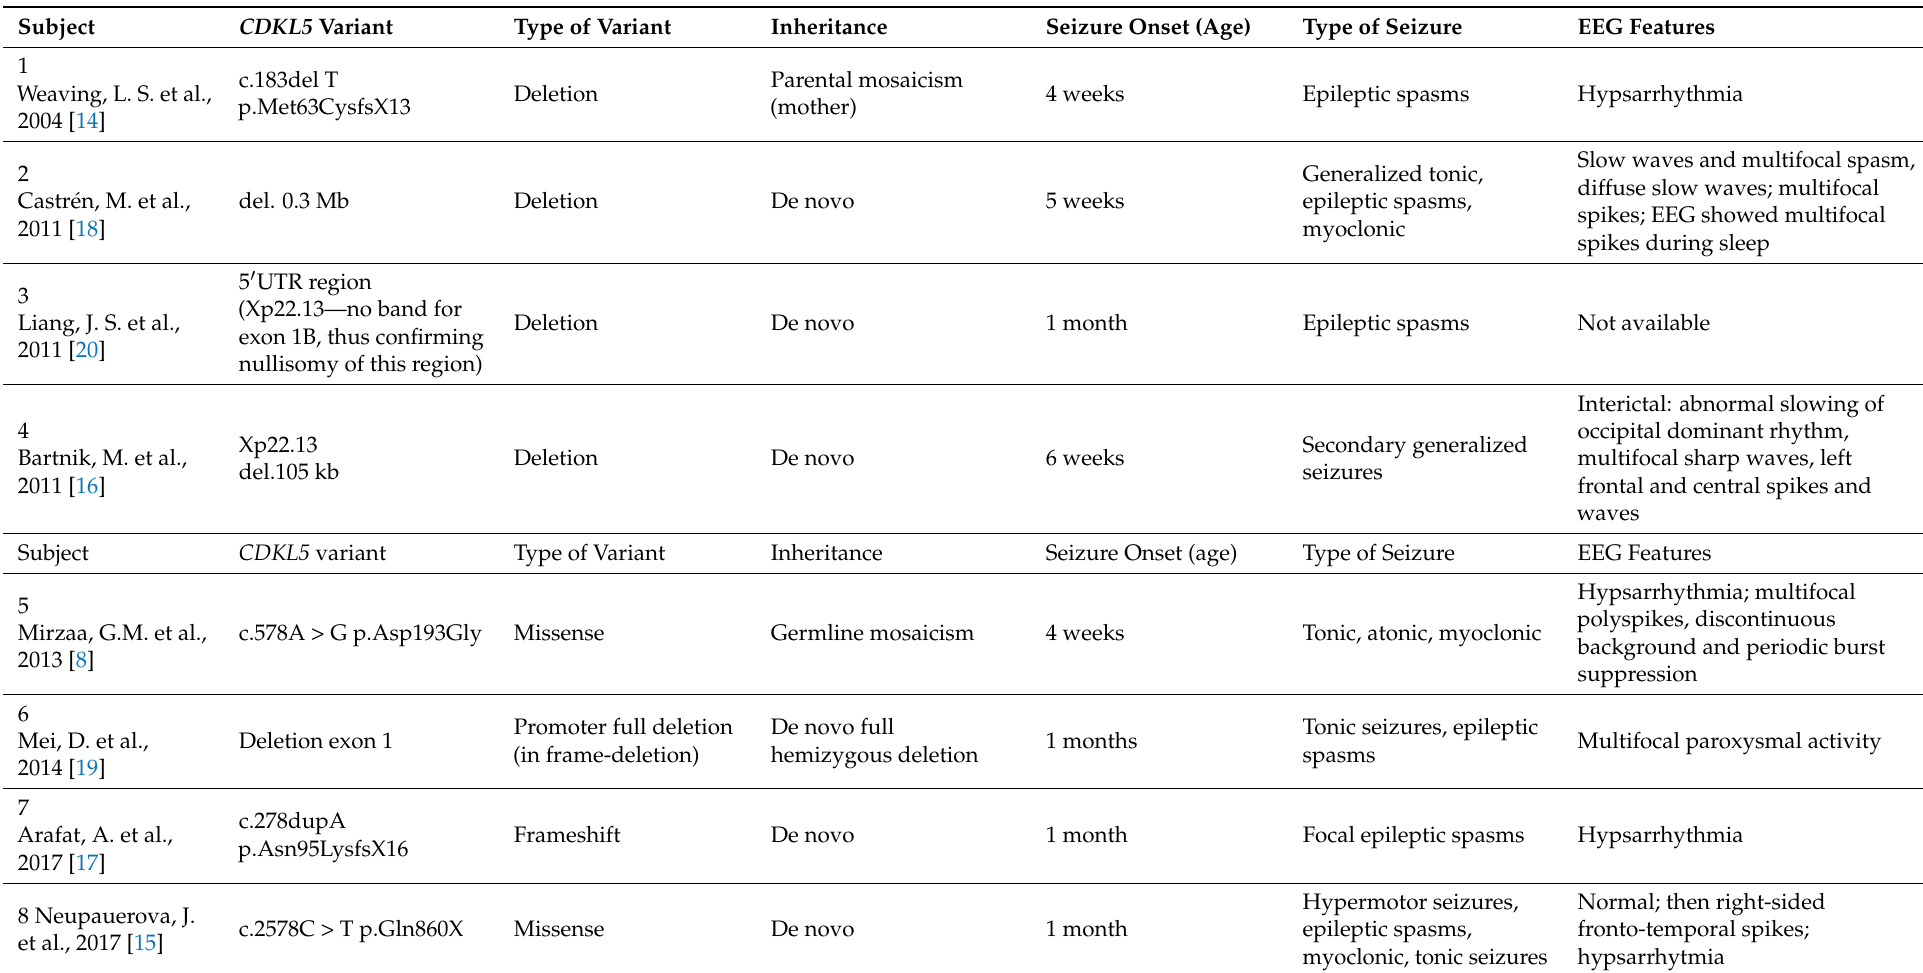
Table 1. Molecular characteristics and clinical phenotypes, EEG patterns, and neuroimaging for fifteen reported variants in male subjects with CDD and the presented